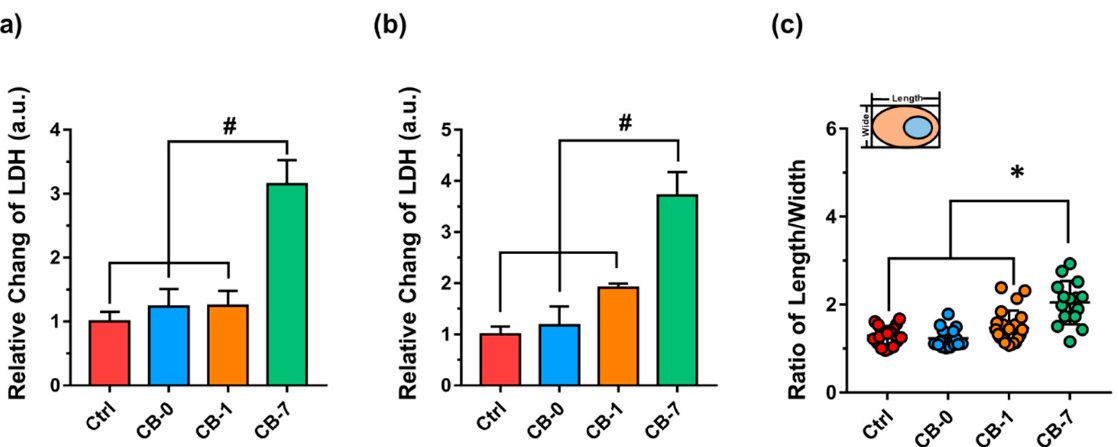
Figure 5. Cellular morphological changes by CB particles in macrophages. ( a , b ) The relative release of LDH from J774A.1 cells in response to CB particles at 5 µg/mL ( a ) and 10 µg/mL ( b ) for 24 h (n = 3). ( c ) Statistics of length to width ratio of J774A.1 macrophages after exposure to CB particles (10 µg/mL) at 24 h from confocal images, with a schematic diagram illustrating the statistical method of the ratio of length/width. All controls are untreated groups. Statistical significance between groups: (*) p < 0.05 and (#) p < 0.001, relative to the untreated control. Abbreviations: CB, carbon black; LDH, lactate dehydrogenase.